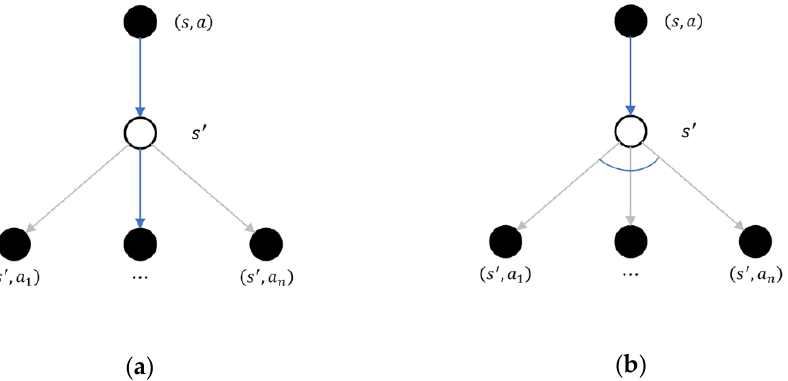
Figure 3. Schematic diagram of the differences in the iteration strategies. ( a ) SARSA’s iteration strategy; ( b ) Q-learning’s iteration strategy.